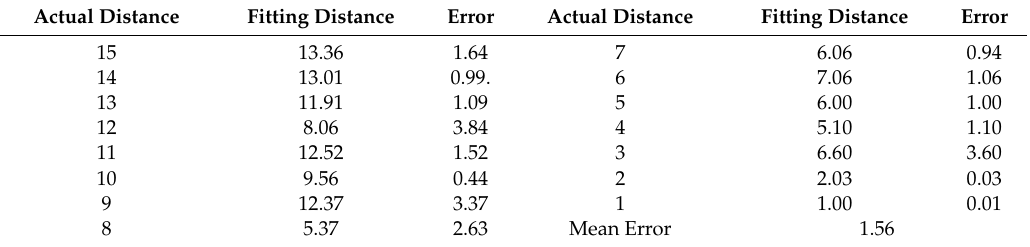
Table 2. The errors between each point and the fitting point after the second fitting in meters.